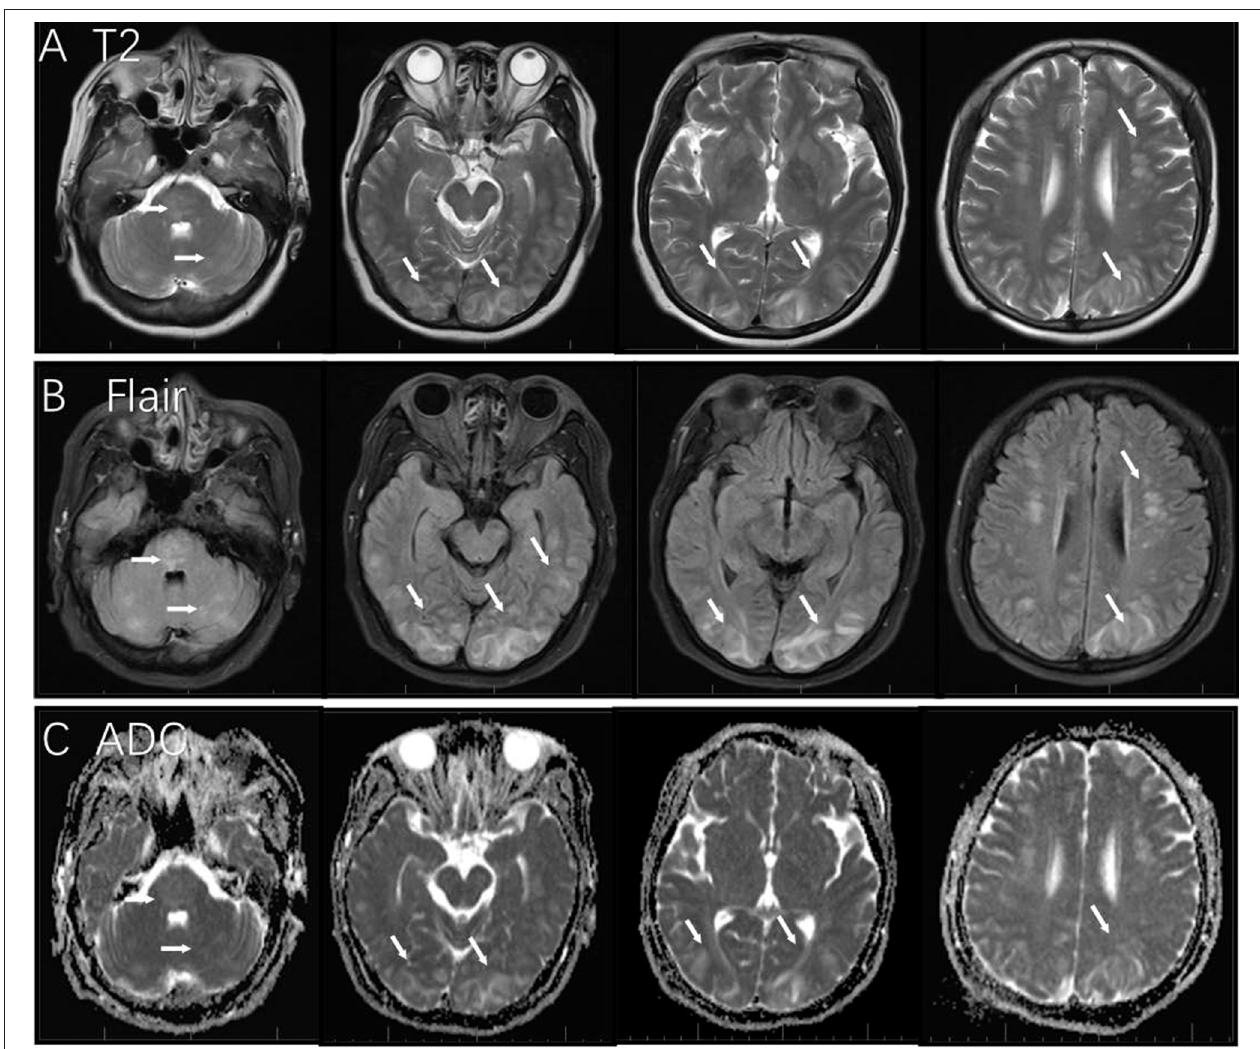
FIGURE 1 | MRI findings in this case of posterior reversible encephalopathy syndrome. T2 and Flair image showed hyperintensity in the area of the cerebellum, pons, fronto-parieto-occipital areas, and corona radiate [white arrows in panels (A,B) ]; bilateral parieto-occipital cortical regions showed hyperintensity in ADC [white arrows in panel (C)